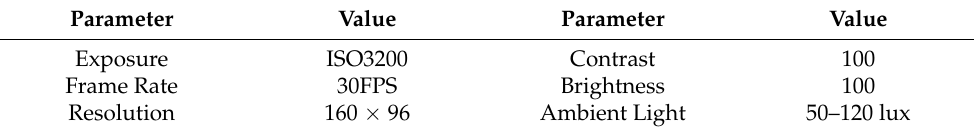
Table 2. Camera Parameter.